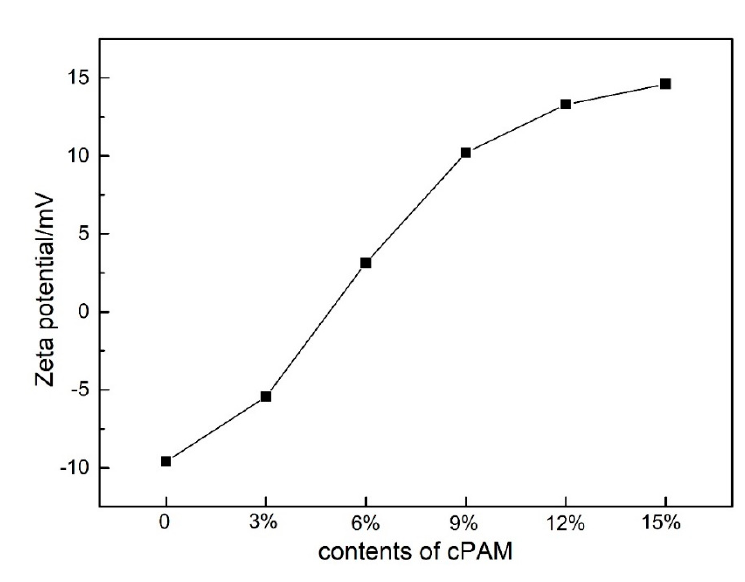
Figure 11. Zeta potential of the PVC biofilm carrier.